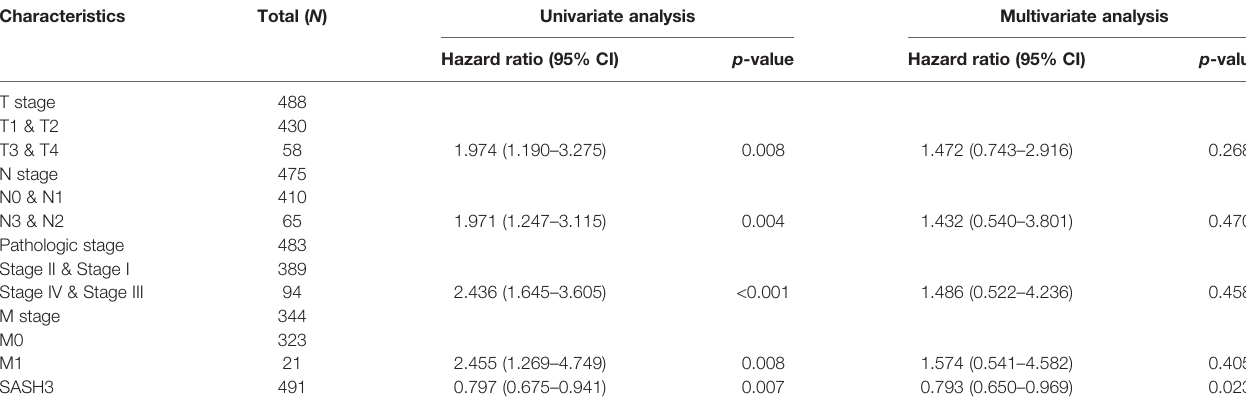
TABLE 2 | Univariate and multivariate Cox regression analyses of different parameters on disease speci fi c survival in LUAD.